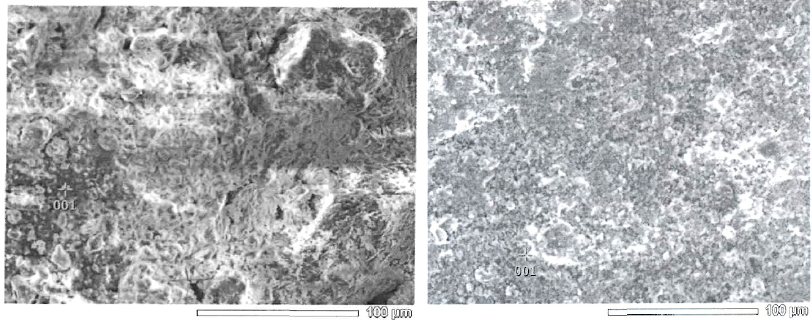
Fig. 9. The microstructure of cemented clay and crystallization - aggregate sample: a) experimental and b) control soil- concrete samples made on the basis of polluted soil with concrete additive ( × 500) .